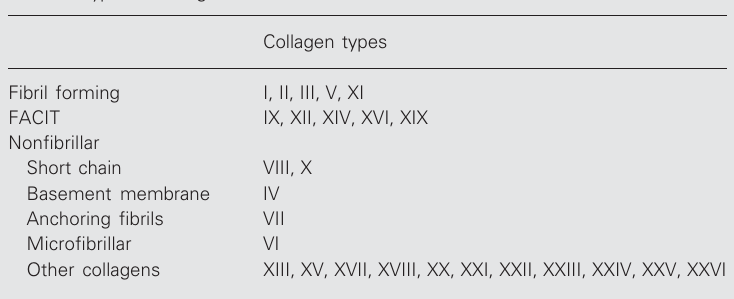
Table 1. Types of